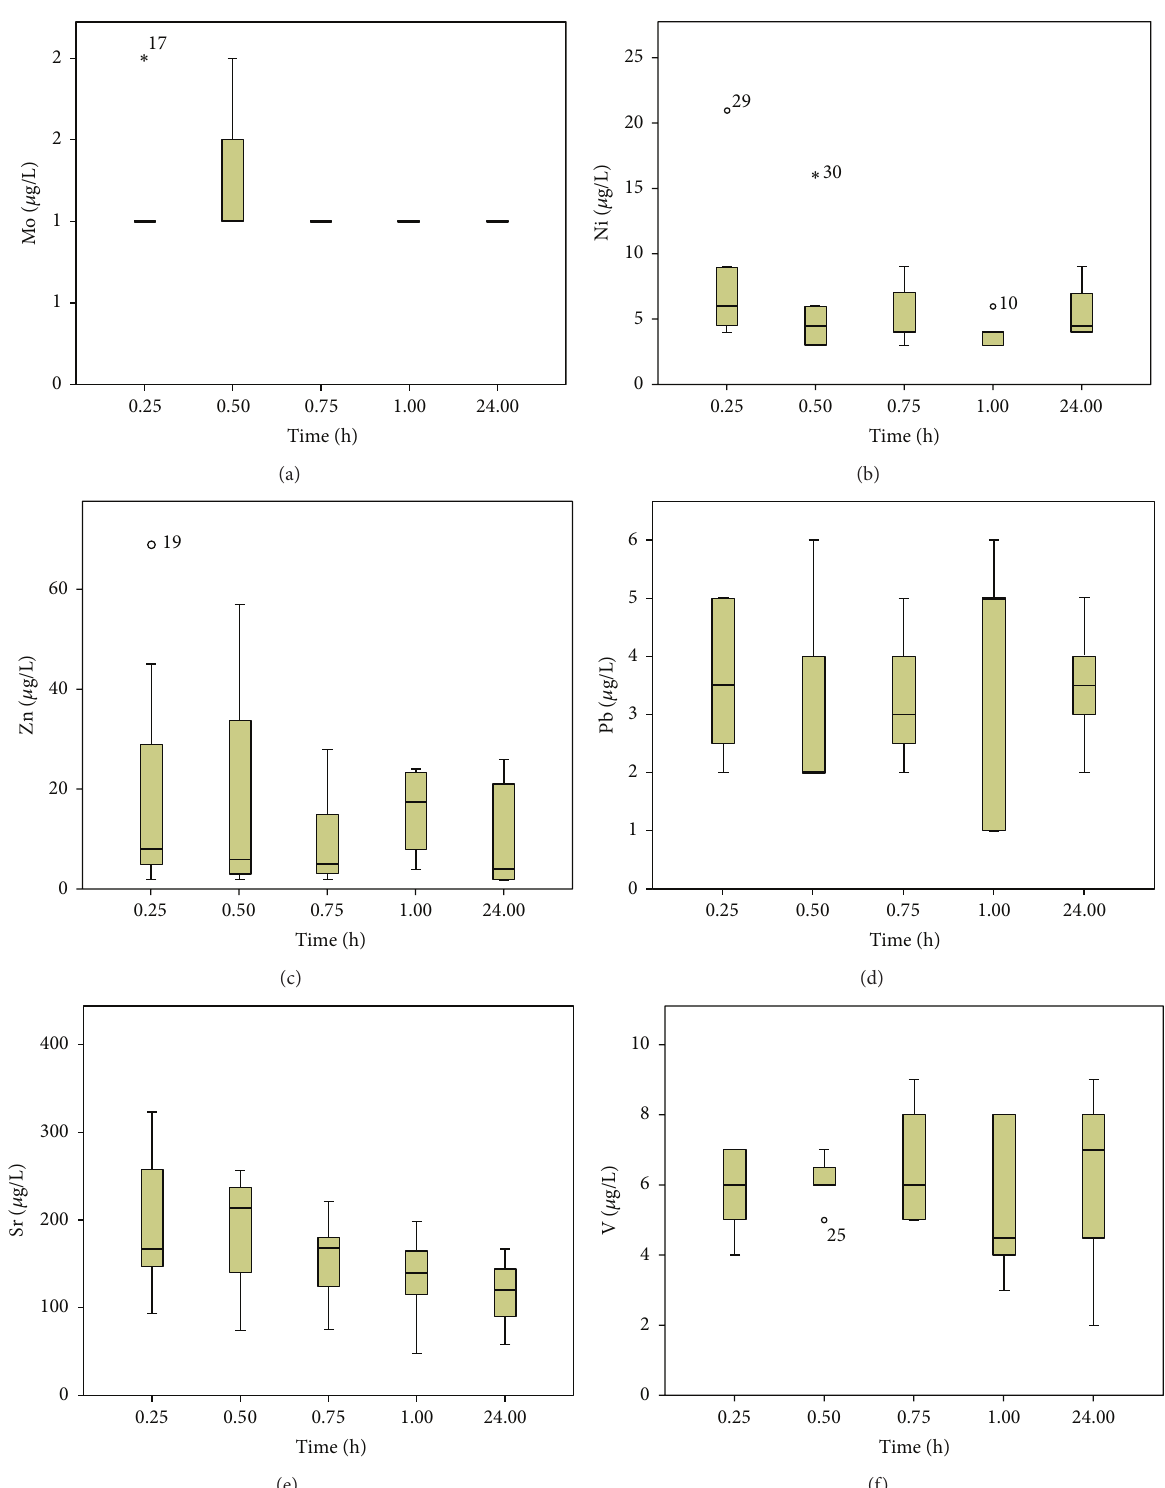
Figure 5: Metals micropollutant (Mo, Ni, Zn, Pb, Sr, and V) variations in runoff samples without the first flush sample in Area A (but with the 50 samples per sampling